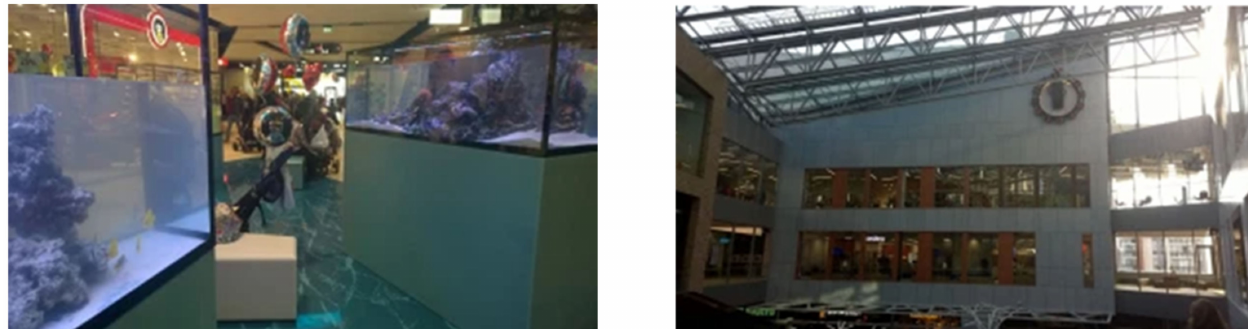
Figure 3. Ideas from youngsters that were realized in Iso Omena—large aquariums ( left ) and a large clock in Iso Omena ( right ). These ideas came from youngsters, and they were planned together with Citycon